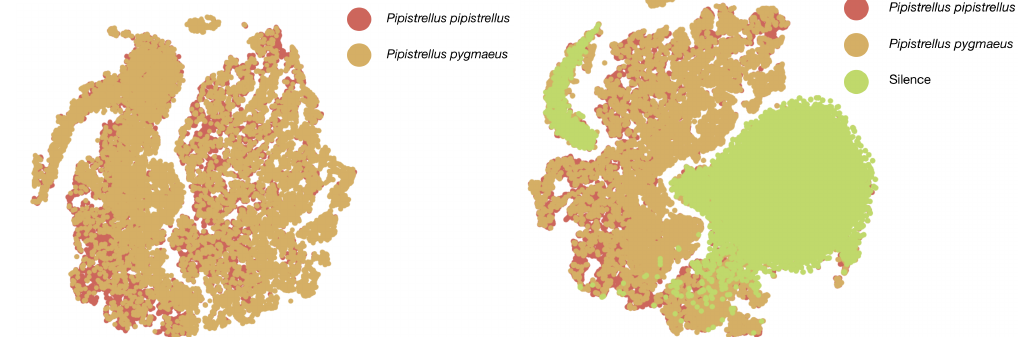
Figure 8. t-Distributed Stochastic Neighbor Embedding (t-SNE) plots displaying the separability of the call pulses of the two bat species and with silent intervals